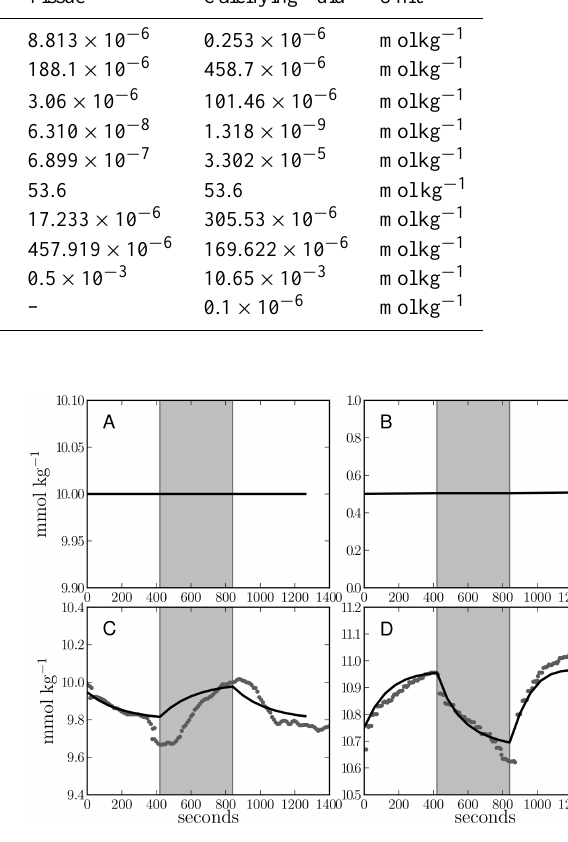
Fig. 3. Simulated calcium ion concentrations over time (black lines) in the four model compartments ( A =seawater; B =tissue; C =coelenteron; D =calcifying fluid). The observations (grey dots) are from the microsensor studies of Al Horani et al. (2003). Light periods range from 0 to 420s and from 840 to 1260s. The dark period is between 420 and